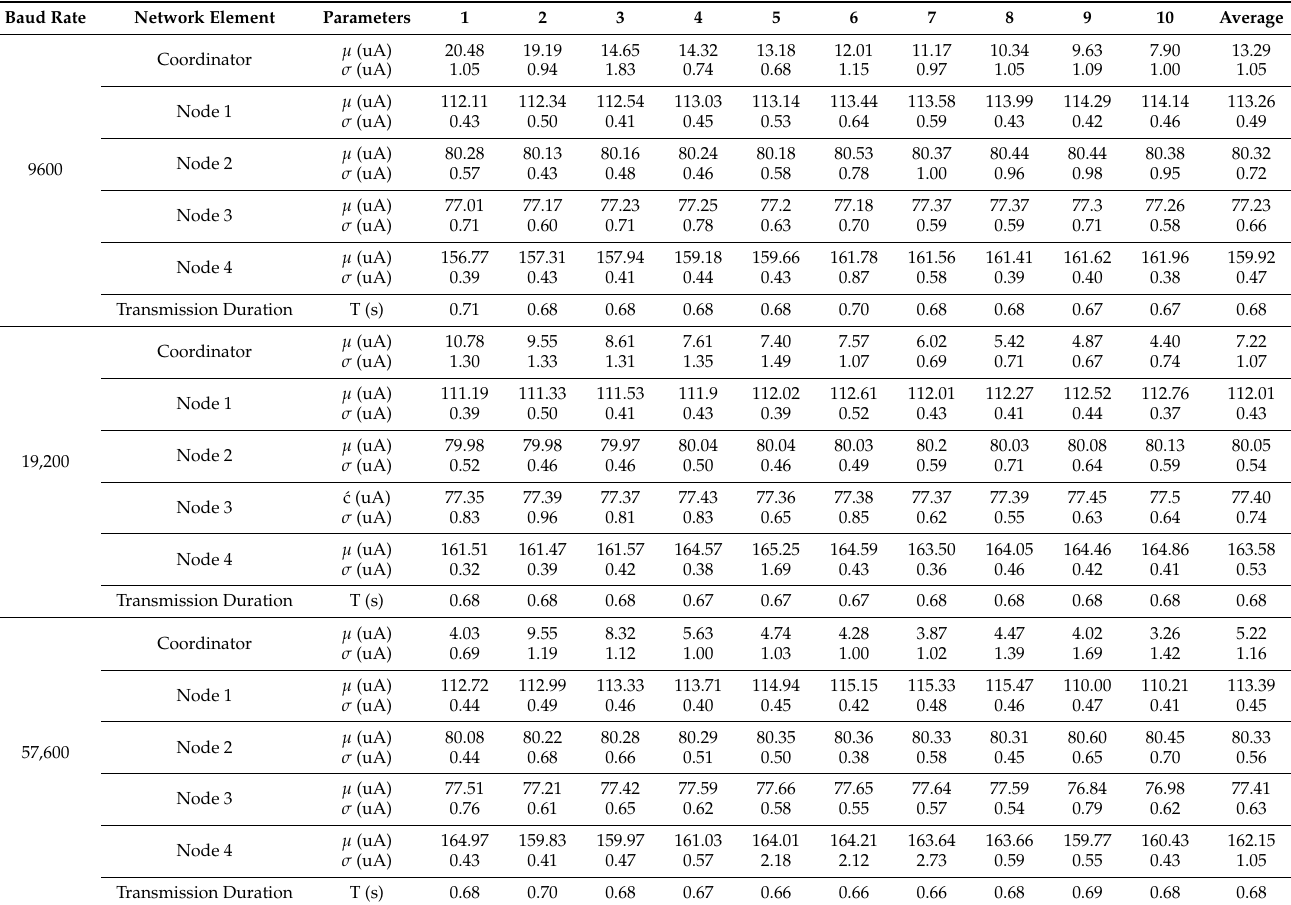
Table 3. Values of energy consumption and transmission duration for the DigiMesh